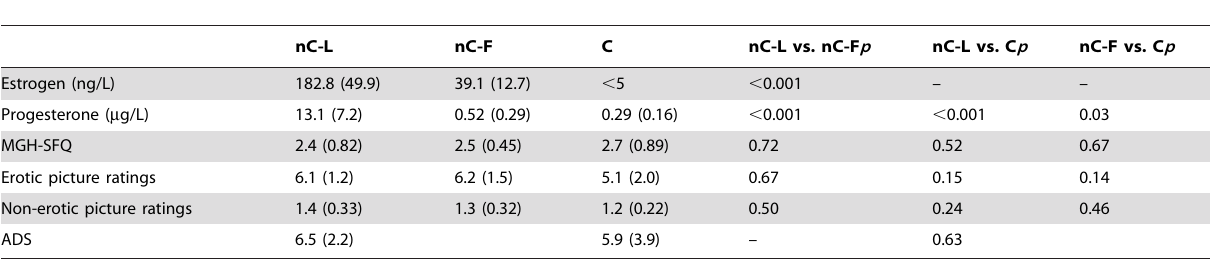
Table 1. Sample characteristics: Hormonal levels and